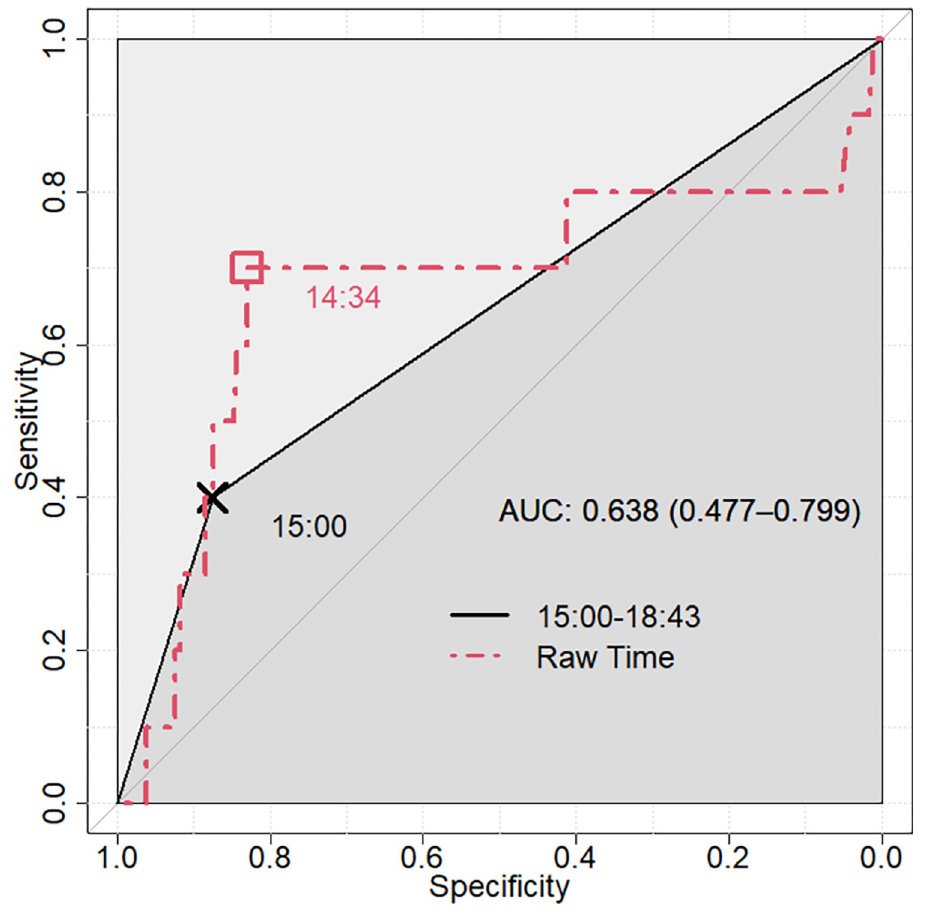
Fig 2. Receiver operating characteristic analysis of postoperative blood transfusion versus case start, performed on both the 15:00 discretization and the raw surgical case start time. Abbreviations: AUC, area under the curve.